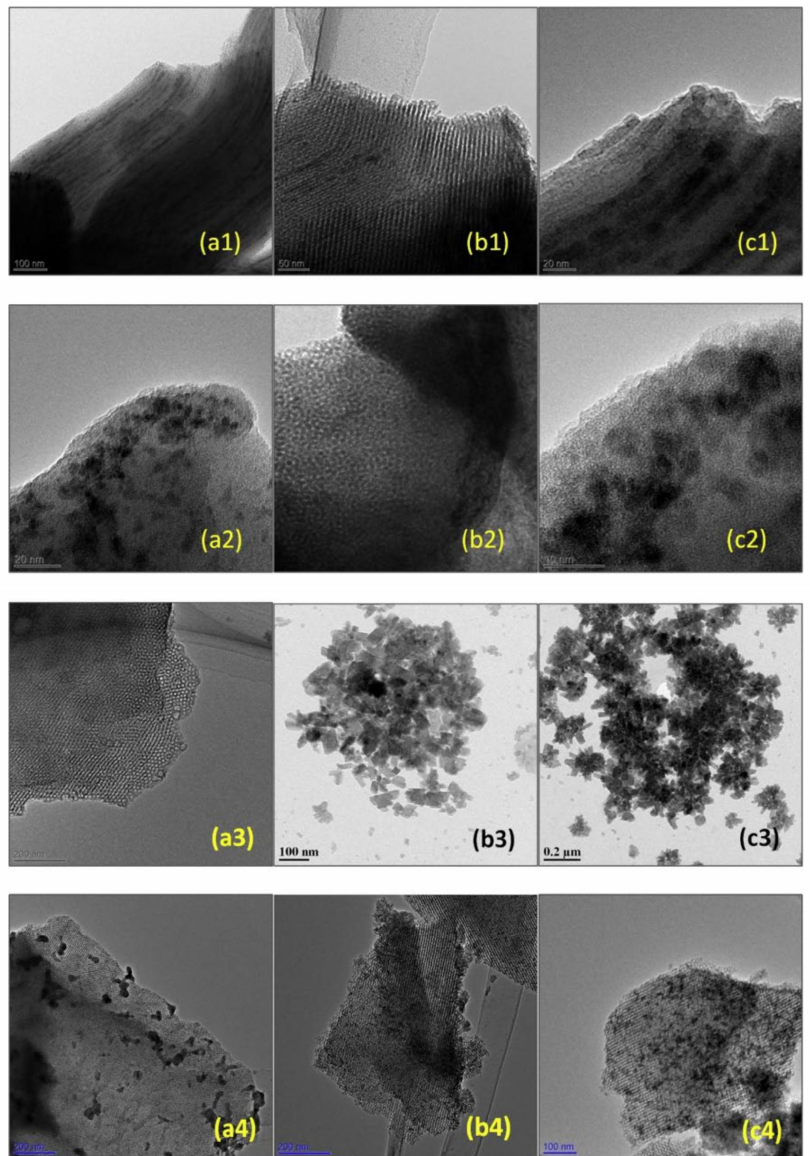
Figure 16. TEM images ( a1 , b1 , c1 ) 20%CoMo/SBA-15; ( a2 , b2 , c2 ) 20%CoMo/KIT-6; ( a3 ) FDU-12; ( b3 , c3 ) 20%CoMo/FDU-12; ( a4 ) 5%CoMo/KIT-6; ( b4 ) 10%CoMo/KIT-6; ( c4 ) 20%CoMo/KIT-6. Re- production with permission from Reference [157]. Copyright (2017) Elsevier